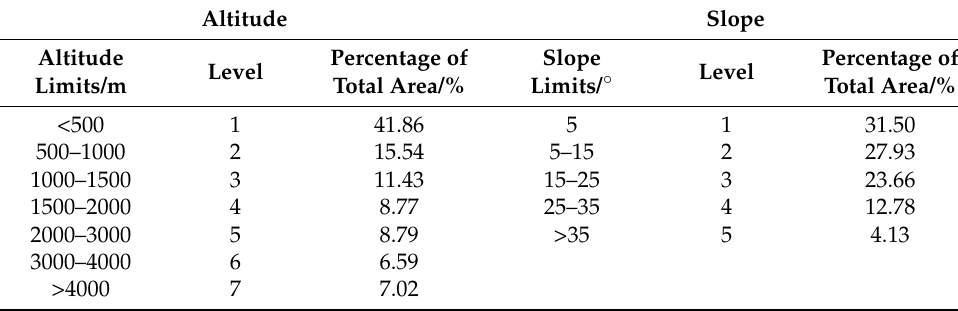
Table 1. Classification of altitude and slope of the Yangtze River Economic Belt.